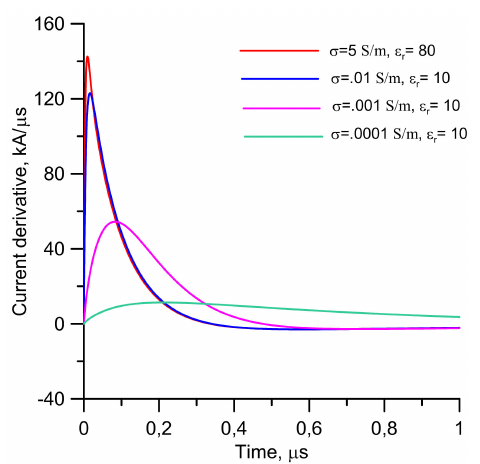
Figure 4. The time derivative of the return stroke current at ground level for four values of the soil conductivity at the strike